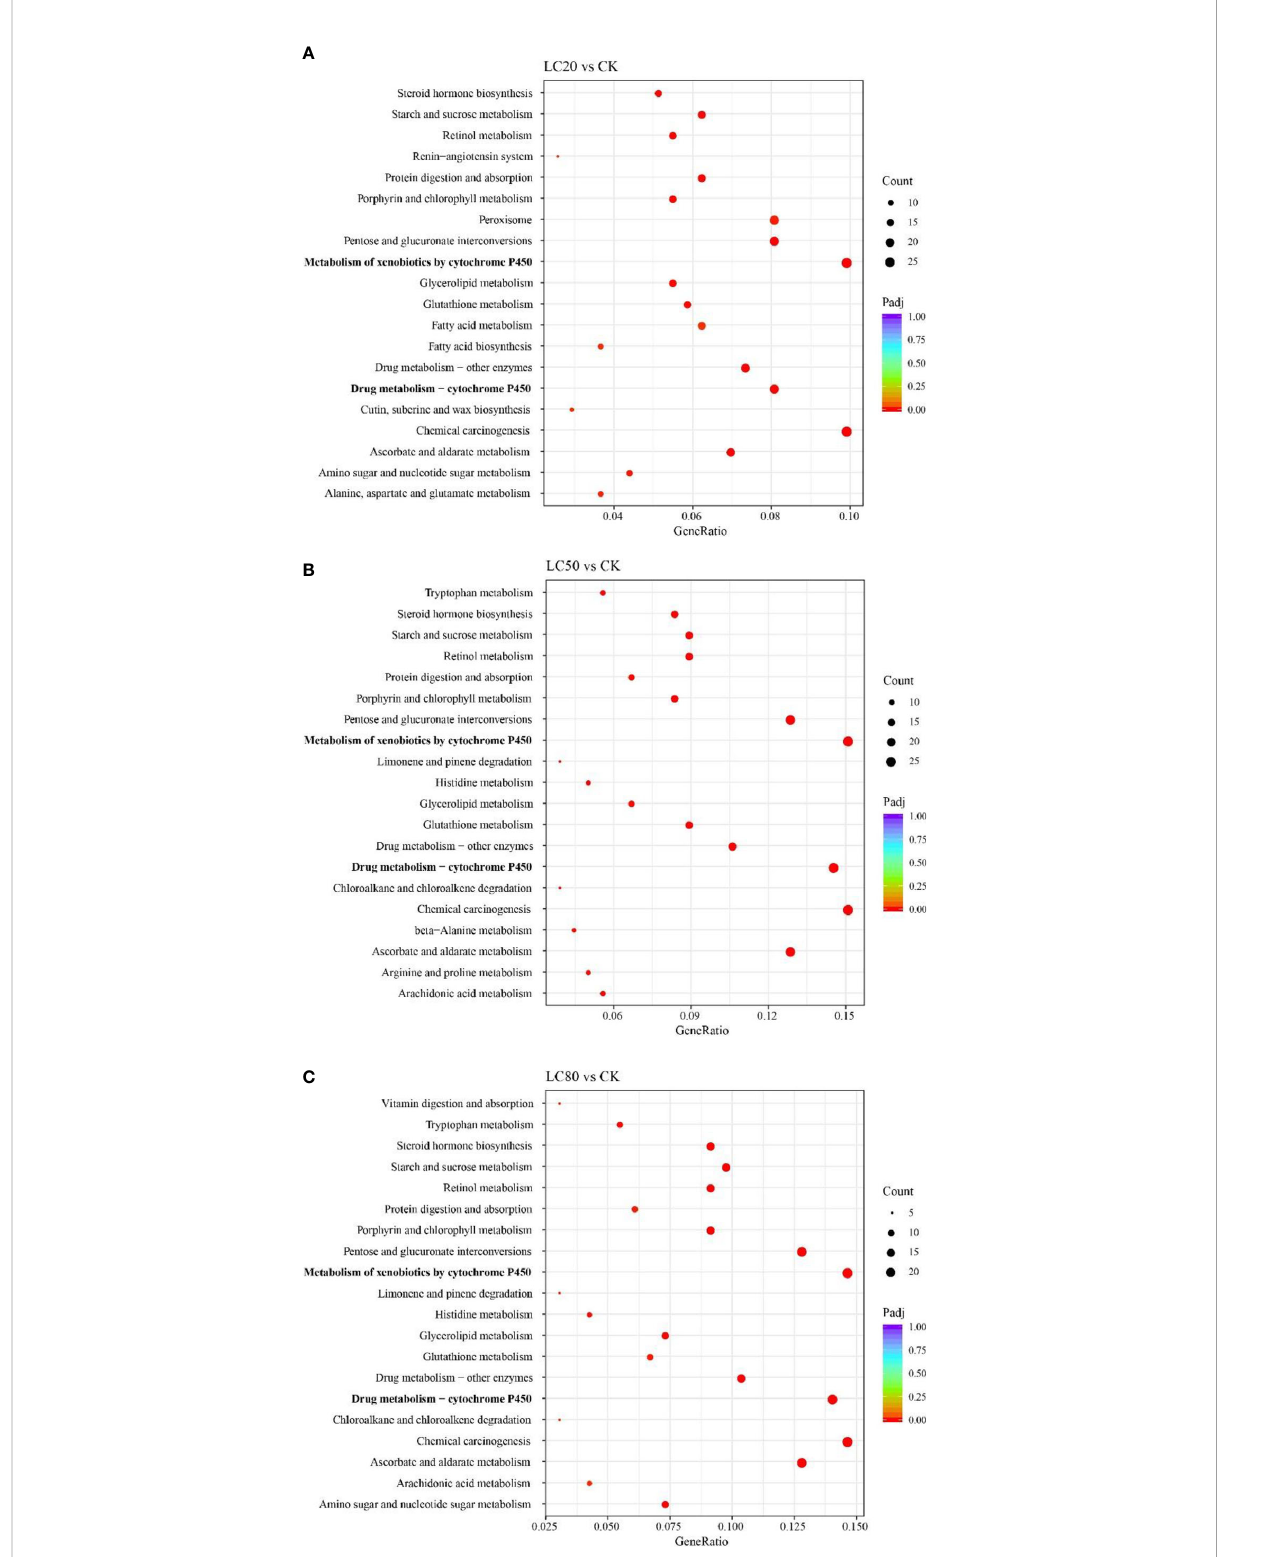
FIGURE 2 KEGG enrichment analyses of DEGs from different comparisons. (A) LC 20 vsCK comparison. (B) LC 50 vsCK comparison. (C) LC 80 vsCK